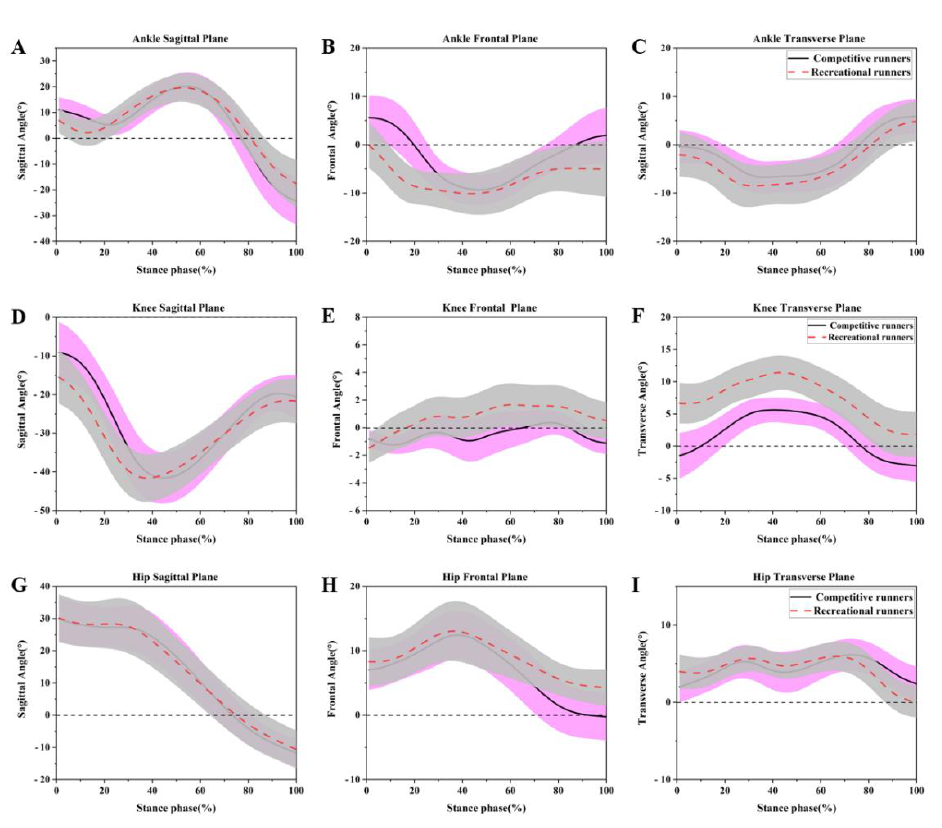
Figure 1. The means and standard deviations for ankle angles in ( A ) sagittal plane, ( B ) frontal plane, ( C ) transverse plane, knee angles in the ( D ) sagittal plane, ( E ) frontal plane, ( F ) transverse plane, and hip angles in the ( G ) sagittal plane, ( H ) frontal plane, ( I ) transverse plane during the running stance phase for the competitive runners (black, solid lines) and recreational runners (red, dashed lines).